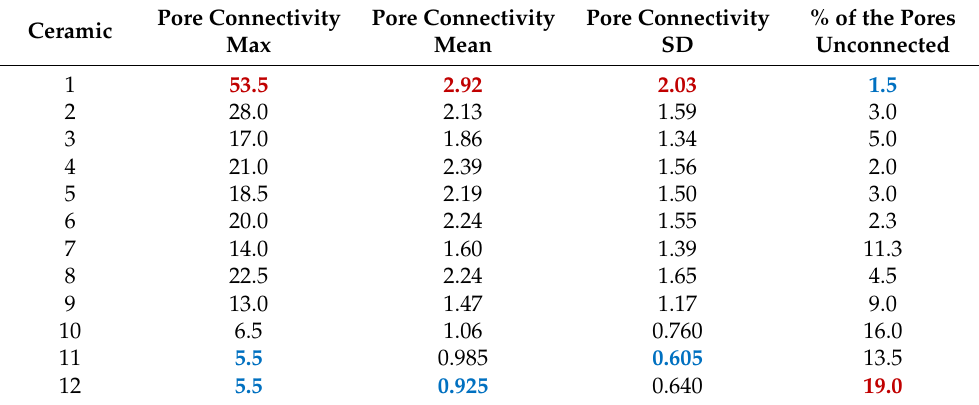
Table 5. Significant ( p < 0.05) connectivity variables; sparse graphs of pores.